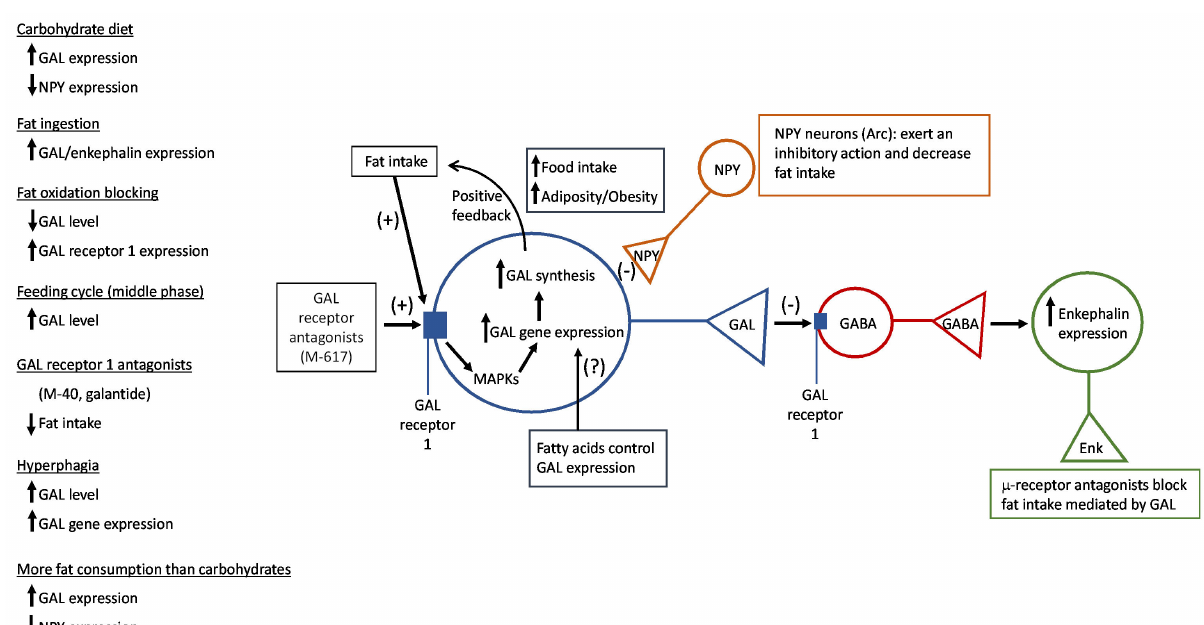
Figure 2. Paraventricular hypothalamic nucleus (PVH): neural pathway and changes in the nucleus after different situations (left side). PVH plays a crucial role in modulating feeding mechanisms. ↑ : increase; ↓ : decrease; +: activation; -: inhibition; ?: action to be demonstrated. GABA: gamma-aminobutyric acid; GAL: galanin; MAPKs: mitogen-activated protein kinases; NPY: neuropeptide